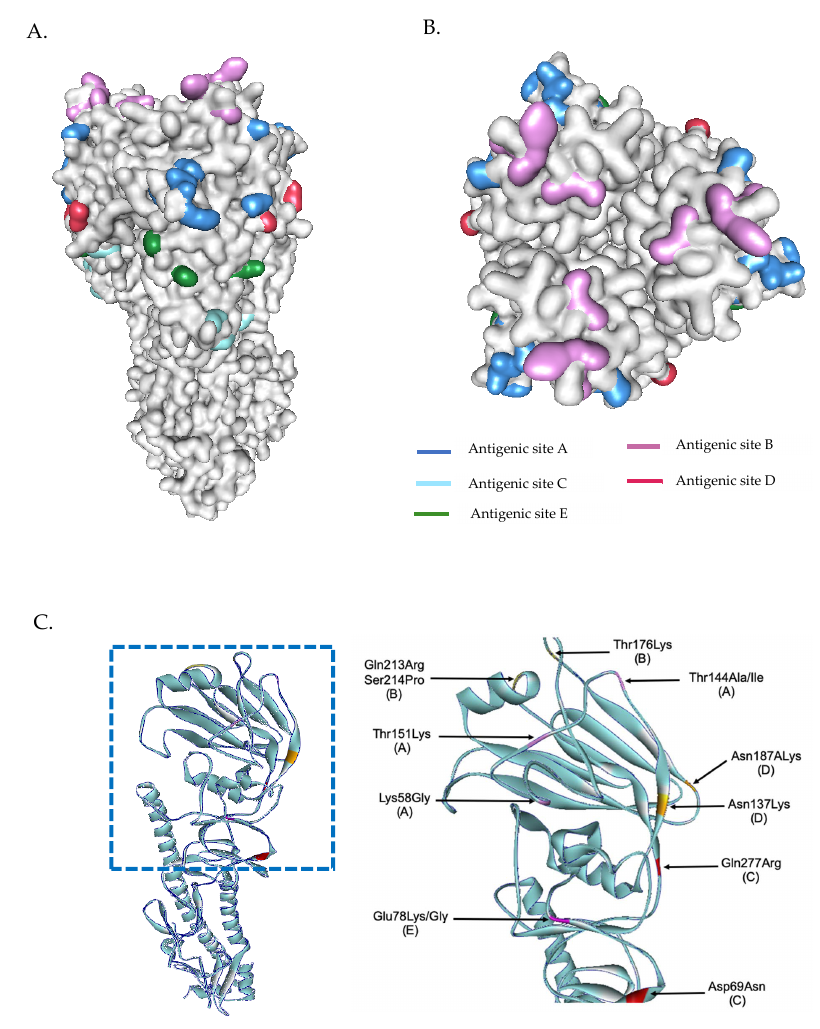
Figure 5. Three-dimensional structural analysis of H3N2 HA protein ( A ). Surface representation of H3N2 showing antigenic sites located in different regions of the HA molecule ( B ). Superimposed HA structures of A/Switzerland/8060/2017 (H3N2) and other isolates (or mutations) where mutations at antigenic sites are highlighted ( C ). HA structures were built based on the structure of A/Victoria/361/2011 (H3N2) influenza hemagglutinin protein (PDB ID: 4O5I).